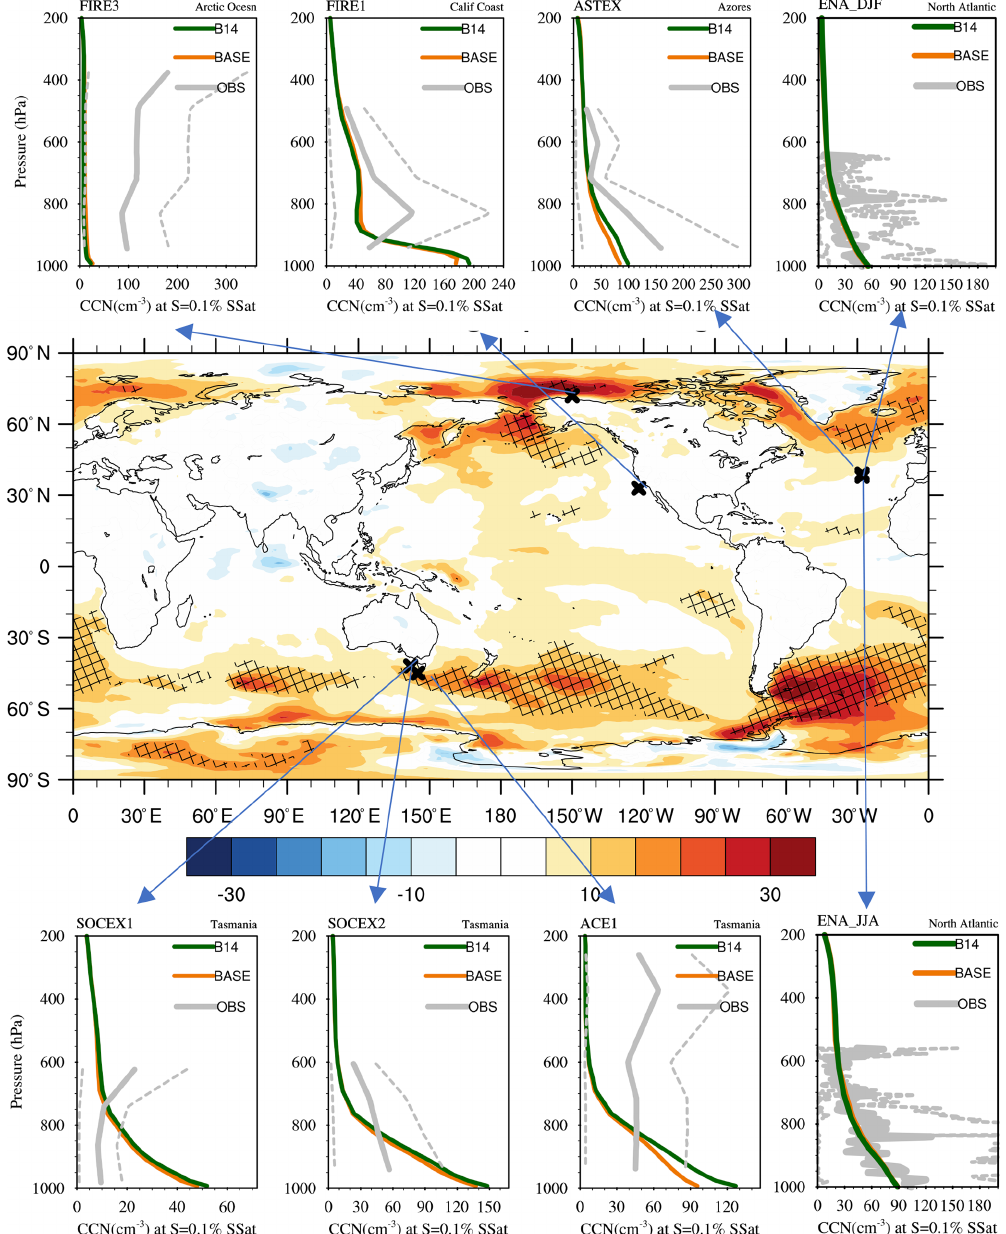
Figure 3. Spatial distribution of annual mean percentage changes of surface CCN concentrations at 0.1% supersaturation due to MOA (by comparing B14_D15 and BASE), and vertical distribution of CCN concentrations at 0.1% supersaturation from eight measurements (solid gray lines), BASE (solid orange line), and B14_D15 (solid green line). Dashed lines outline a range of 10th and 90th percentiles for measurements in the following field campaigns. The FIRE1 (First International Satellite Cloud Climatology Project Reginal Experiment), which was located at 33 ◦ N and 238 ◦ E on the California coast; the data were collected during June and July 1987. The FIRE3, which was located at 72 ◦ N and 210 ◦ E in the Arctic Ocean; the data were collected during May 1998. The ASTEX (Atlantic Stratocumulus Transition Experiment), which was located at 38 ◦ N and 332 ◦ E in the Azores; the data were collected during June 1992. The SOCEX1 (Southern Ocean Cloud Experiment), which was located at − 42 ◦ S and 142 ◦ E in Tasmania; the data were collected during July 1993. The data of SOCEX2 were collected during January and February 1995. The ACE1 (Aerosol Characterization Experiment), which was located at − 45 ◦ S, 145 ◦ E in Tasmania; the data were collected during November and December 1995. The ENA_JJA (Eastern North Atlantic), which was located at 39 ◦ N and 332 ◦ E in the eastern North Atlantic (the data were collected from June to August), while ENA_DJF data were collected